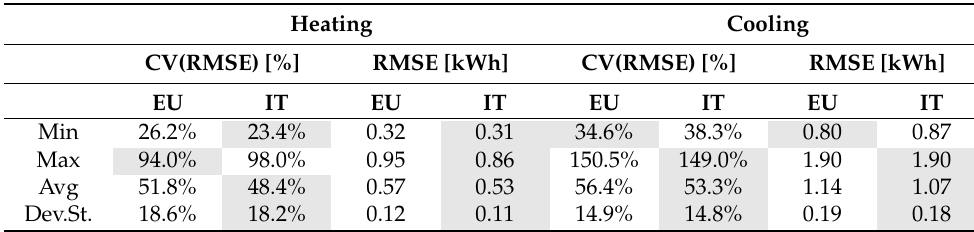
Table 7. Minimum, maximum, average and standard deviation value of CV(RMSE) and the RMSE of both methods of EN ISO 52016 (Annex A and Annex B). Case study with g gl,n = 0.77. The gray cells show the best percentages.